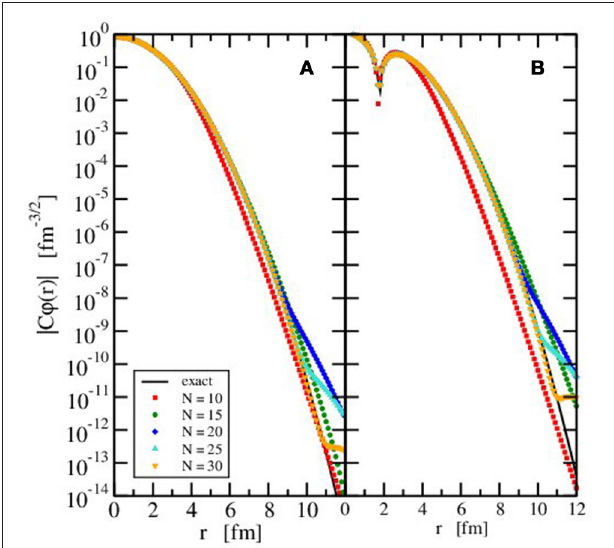
FIGURE 1 | Modulus of the scaled radial wave function of the ground (A) and first excited (B) state with orbital angular momentum l symmetric relativistic harmonic oscillator with m 938 MeV/ c 2 in the exact case (full black line) and the calculation with the = Lagrange-mesh method for different scale parameters h (colored symbols) and constant number of grid points ( N explained in the text.